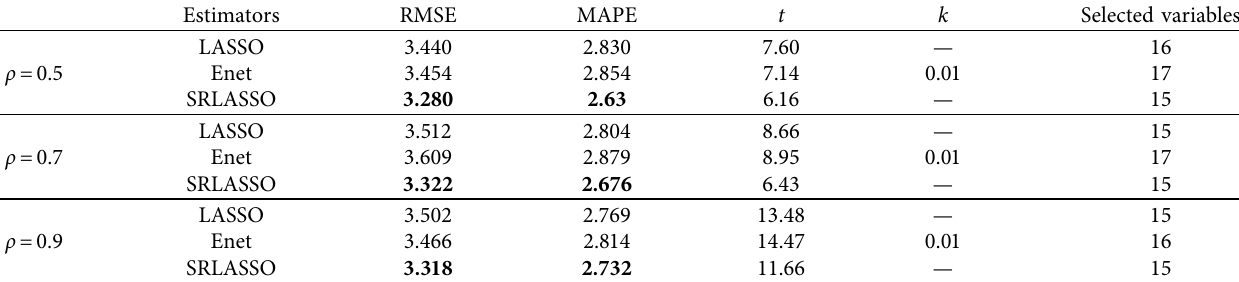
Table 1: Median cross-validated RMSE and MAPE values.